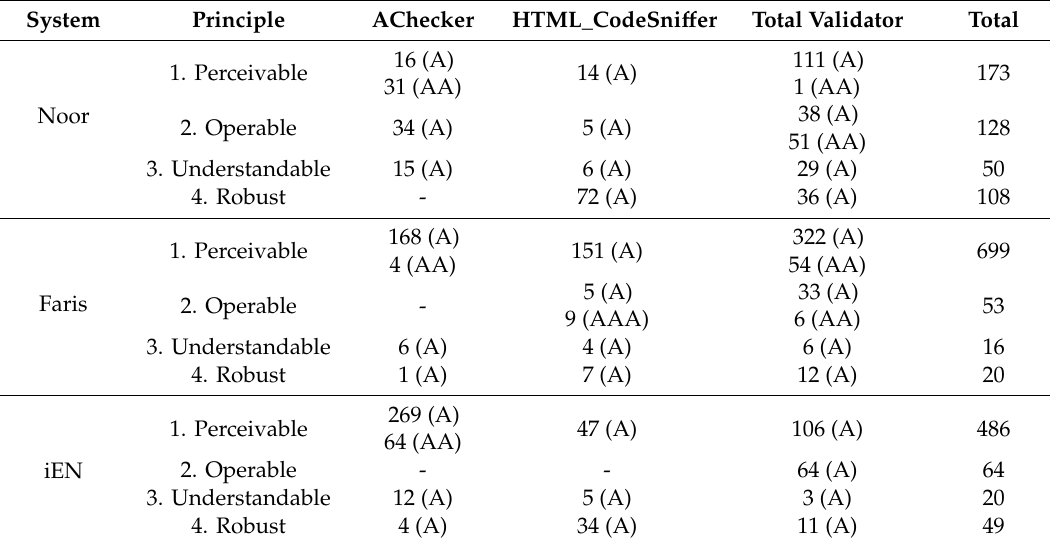
Table 7. Total number of errors based on the